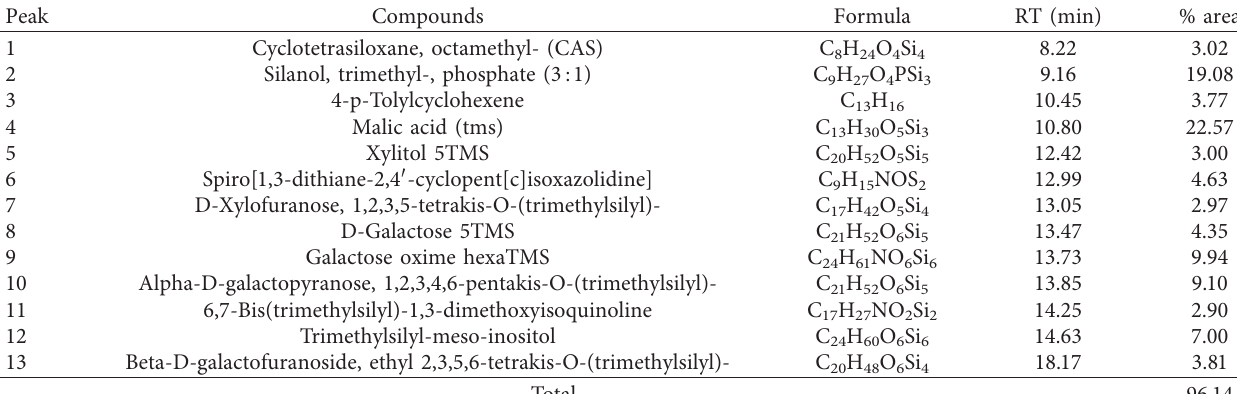
Table 1: Phytochemical composition of M. vulgare extract.